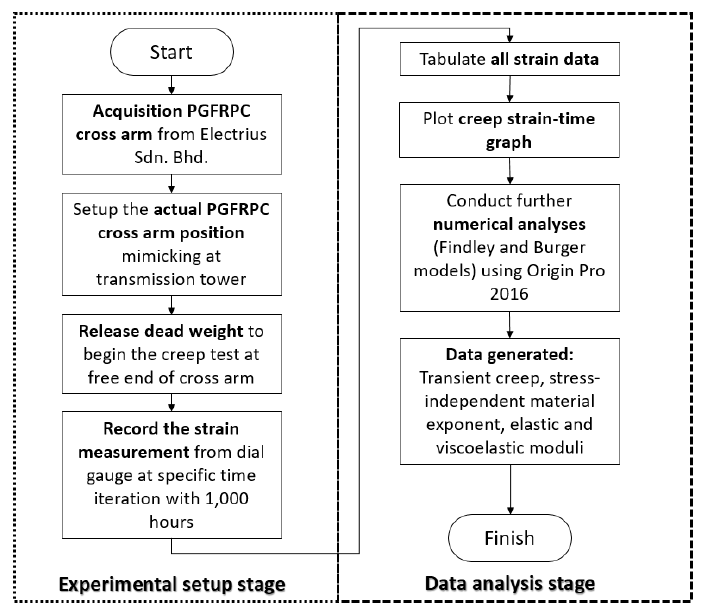
Figure 1. Flow chart of the research methodology.